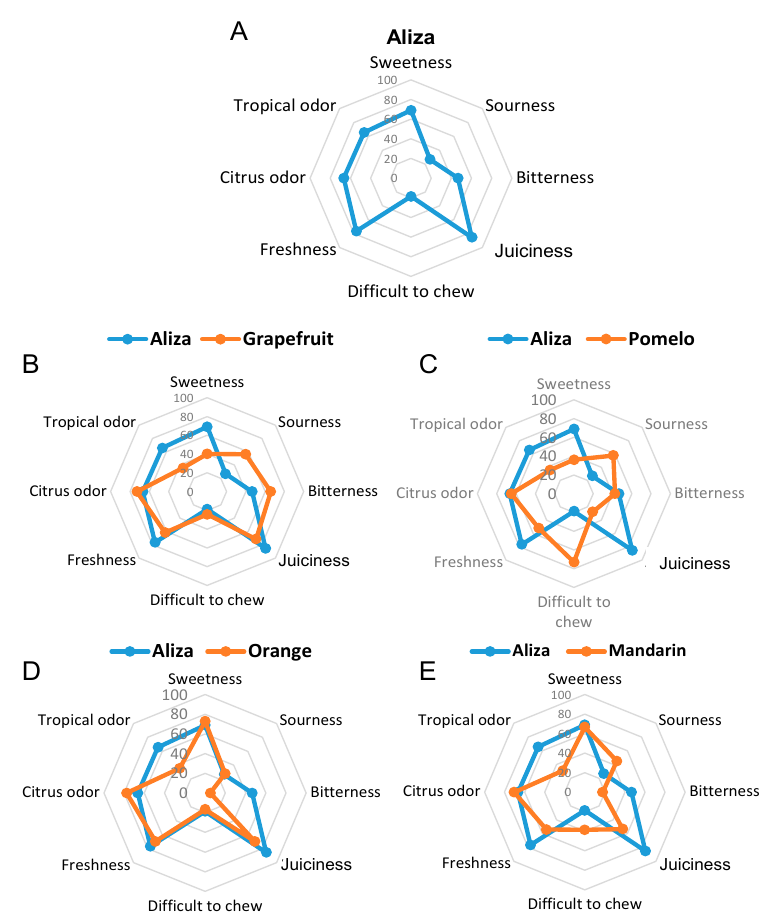
Figure 3. Flavor profiles of ‘Aliza’, grapefruit, pomelo, orange and mandarin fruits. ( A ) ‘Aliza’; ( B ) ‘Aliza’ and grapefruit; ( C ) ‘Aliza’ and pomelo; ( D ) ‘Aliza’ and orange; ( E ) ‘Aliza’ and mandarin. Flavor profiles were evaluated by a trained sensory panel and data are means of the scores assigned by 10 testers.